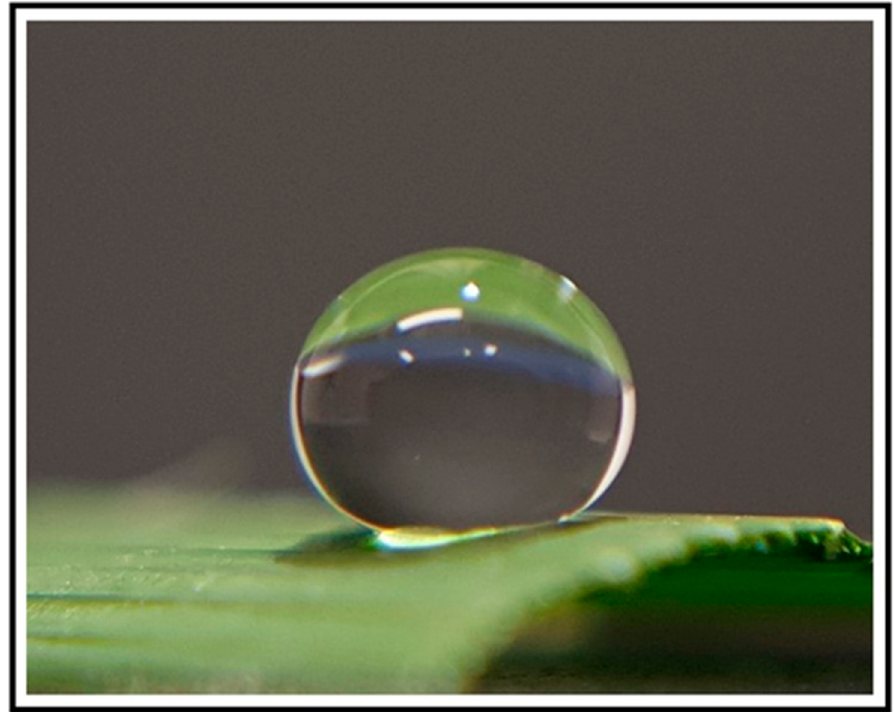
Figure 4. High hydrophobicity exhibited by a vegetal material ( C. aurea ). Rose petals have hierarchical structures with micro-papillae of around 20µm in di- ameter and nanometric cuticular folds of around 730 nm in width [98,99]. Such hierar- chical surface is responsible for the “rose petal effect”, in which water droplets are highly adhered to the superhydrophobic surface of the petal (Figure 5b) [96,97]. Chemical analy- sis from Rosa rugosa show that the petals are composed by phenolic acids, tannins, flavo- noids, carotenoids and polysaccharides [99]. Rice leaves show papillae around 5–8 µm in height on the surface, which are arranged in one-dimensional parallel order. The sublayer shows nanometric pins proportionally distributed to enhance the amount of air trapped in the surface [93]. Taro leaves show elliptic protrusions with diameters of around 10 µm uniformly distributed in nest-like caves and nanometric pins disseminated on the surface, resulting in a hierarchical structure [93]. The chemical composition of taro leaves includes the presence of phenolic acids, flavonoids, saponins, tannins and alkaloids [100]. The S. molesta leaf is covered by hairs capped with a crown-like structure on the upper side. Each hair is composed by a 1.5 mm-long stalk and the tip exhibits four rounded filaments con- nected at the apex, which form a crown-like structure of about 500 µm in height [101]. Table 2 summarizes the topographic features of some vegetal materials that have been used to topographically modify the surface of biomaterials.